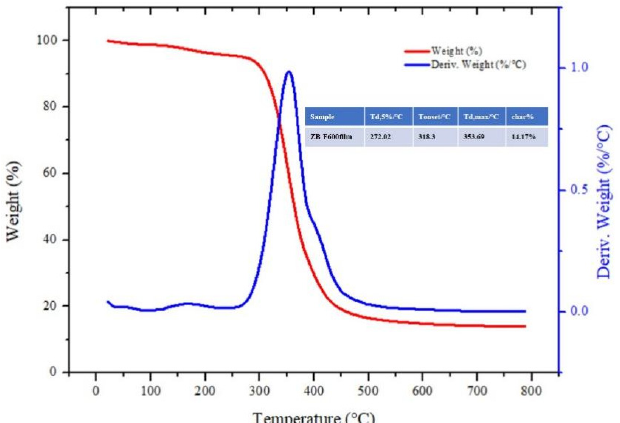
Figure 7. TG and DTG curves of pure ZB ‐ F600 under nitrogen.